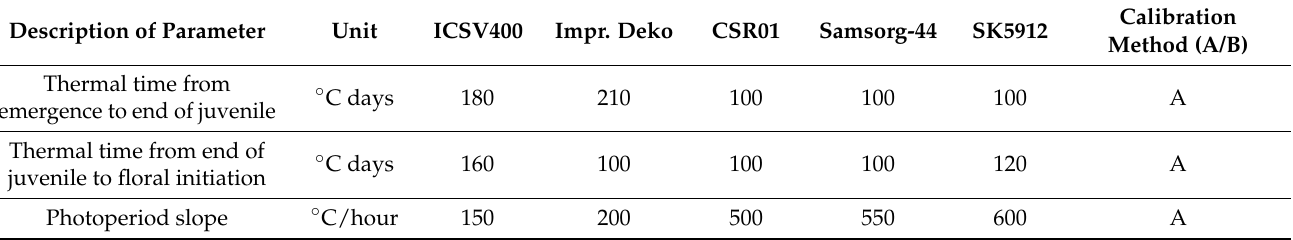
Table 1. Genetic coefficients of sorghum cultivars calibrated in the APSIM-sorghum model. Description of